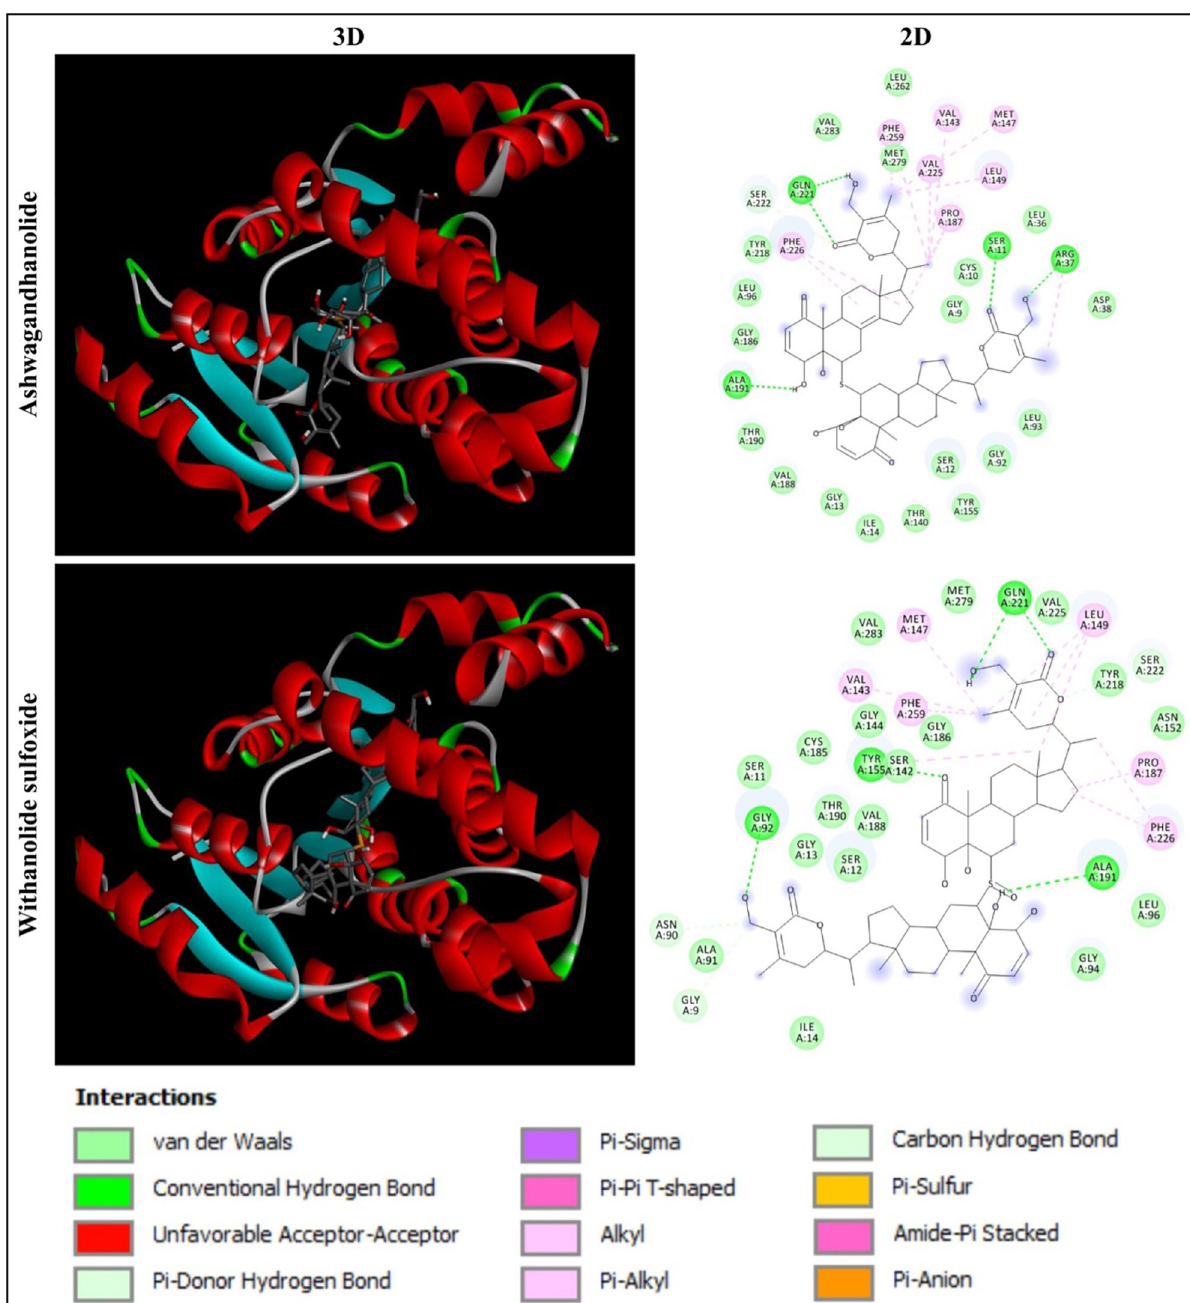
Fig 5. Interaction of human 17 β -HSD1 (PDB: 1FDW) with Ashwagandhanolide and Withanolide Sulfoxide. Three-dimensional (3D) illustration shows the interaction of ligands with human 17 β -HSD1 structure and two-dimensional (2D) diagram displays the interactions of the ligand with the specific amino acid residues in the active site of the